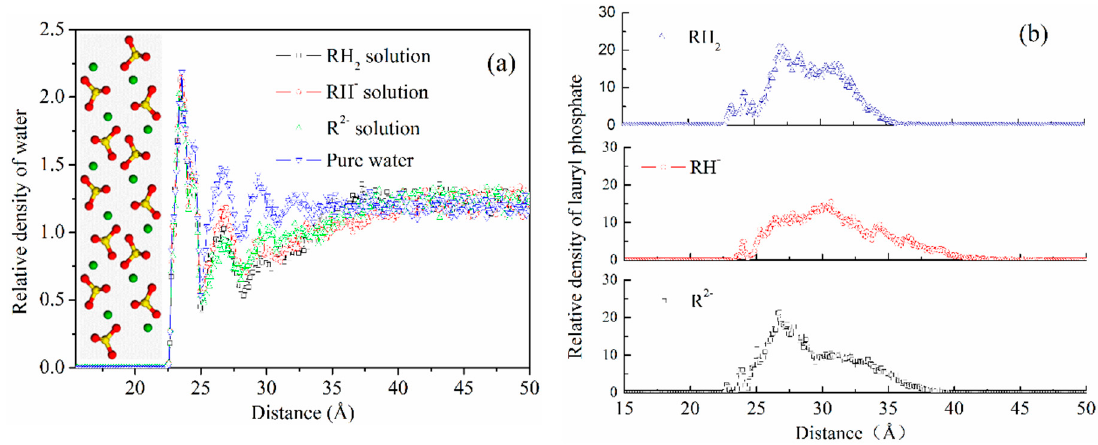
Figure 6. Relative density distribution of molecules/atoms along the normal to barite (001) basal plane surfaces. Water ( a ) and lauryl phosphate species ( b ).